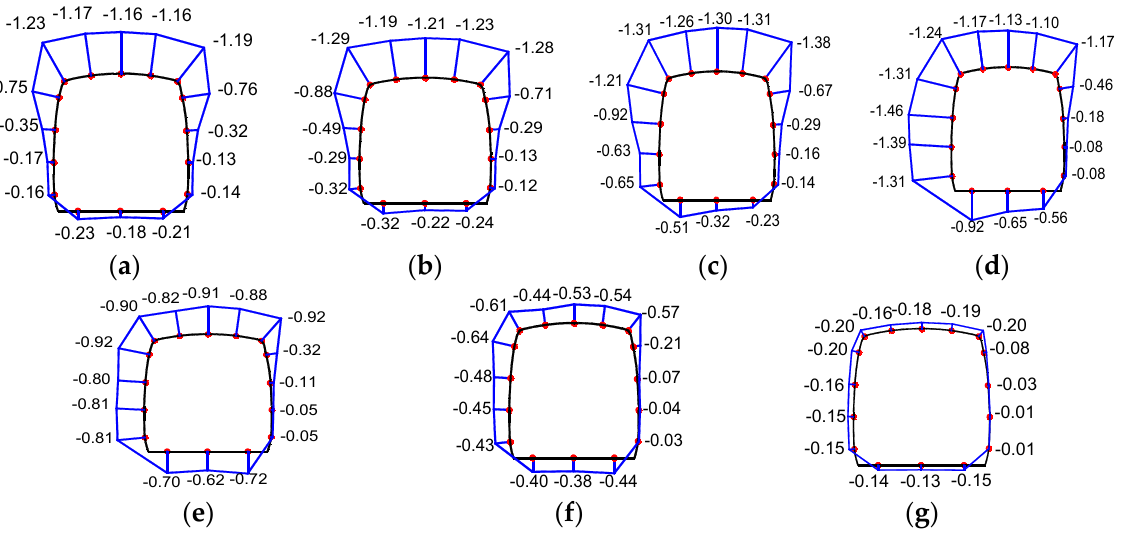
Figure 11. Mean pressure coefficients at the middle section as distance from the tornado’s center to the train car changes ( S = 0.35, λ = 0). ( a ) R/R c = 0; ( b ) R/R c = 0.5; ( c ) R/R c = 1; ( d ) R/R c = 1.5; ( e ) R/R c = 2; ( f ) R/R c = 2.5; ( g ) R/R c = 3.75.